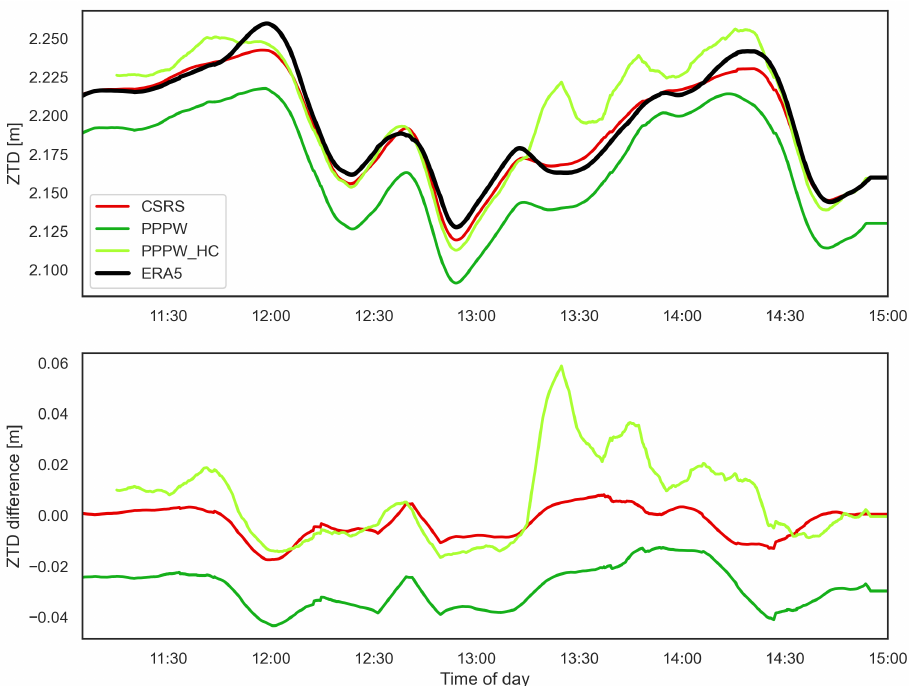
Figure 10. Comparison between estimated GNSS-ZTD (CSRS-PPP (red) and PPPW (green)) and ERA-ZTD (black) for CS2, Top : ZTD, bottom : differences between GNSS-ZTD with respect to